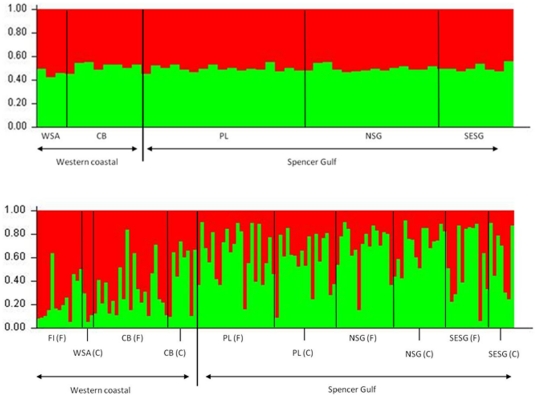
STRUCTURE results for a) bottlenose dolphin carcasses from Spencer Gulf and western coastal areas, South Australia; and b) combined datasets from bottlenose dolphin carcasses and free-ranging individuals, Spencer Gulf and western coastal areas, South Australia.Each vertical column represents one individual dolphin, and the separation of the column into two colours represents the estimated probability of belonging to one or the other population. F = free-ranging dolphins, C = carcasses. Specific geographic locations where dolphins were found or biopsied: FI = St Francis Isles, WSA = western South Australian coast, CB = Coffin Bay, PL = Port Lincoln, NSG = North Spencer Gulf, SESG = southeast Spencer Gulf. See Figure 1 for geographic locations.